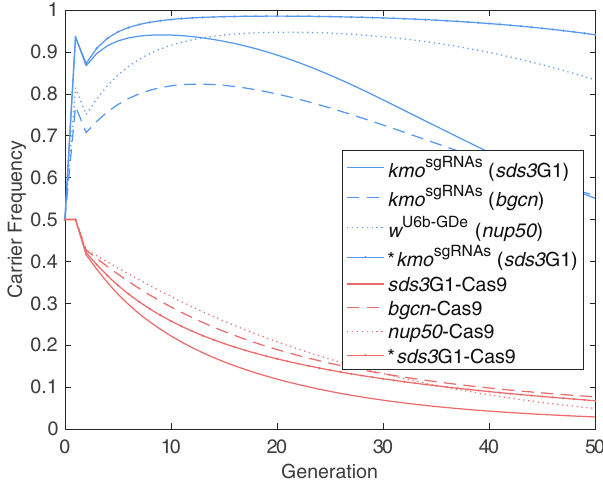
Fig. 4 | Model predicted split drive dynamics using sds3 G1-Cas9, nup50 -Cas9 and bgcn -Cas9. Red lines represent carrier frequencies for the Cas9 elements, while blue lines represent the resulting carrier frequencies of the kmo sgRNAs or w U6b-GDe elements. Here, results for kmo sgRNAs ; bgcn -Cas9 (dashed lines) are identical to those previously reported and the computational simulations were shown to approximate the experimental cage data 13 . Results for nup50 -Cas9; w U6b-GDe (dotted line) are based on parameter values listed in Li et al. 10 . and kmo sgRNAs ; sds3 G1-Cas9 (solid lines)arepredictionsbased onexperimentaldatageneratedhere.Solidlines markedwithdotsdisplayhypotheticalresultsfora kmo sgRNAs ; sds3 G1-Cas9systemin which kmo sgRNAs fi tness costs are reduced to levels observed for w U6b-GDe (marked with * in the fi gure legend). Parameter values for all scenarios are detailed in Sup- plementary Note